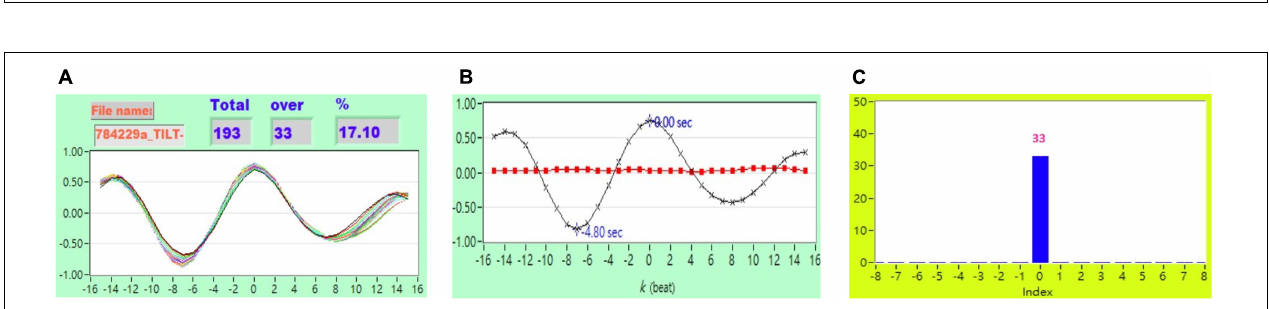
FIGURE 5 | (A) Representative plot of CCF curves with thresholding [–5 (cid:53) k (cid:53) 5 and CCF(k) > 0.5], (B) mean CCF value ( x ) and SD ( (cid:4) ), and (C) distribution bar chart of maximum CCF index during tilt in a healthy subject.